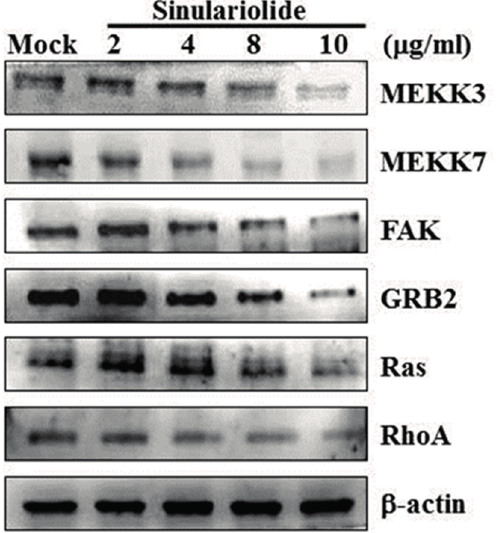
Figure 5. The effects of sinulariolide on GRB2 and FAK signaling pathways. The HA22T cells were treated with different concentration of sinulariolide (0, 2, 4, 8, 10 μ g/mL), and cell lysates were collected for Western blotting assay. The GRB2 and FAK related proteins were validated, including MEKK3, MEKK7, FAK, GRB2, Ras, and RhoA. All the protein levels were all decreased after being treated by sinulariolide in HA22T cells. β -Actin